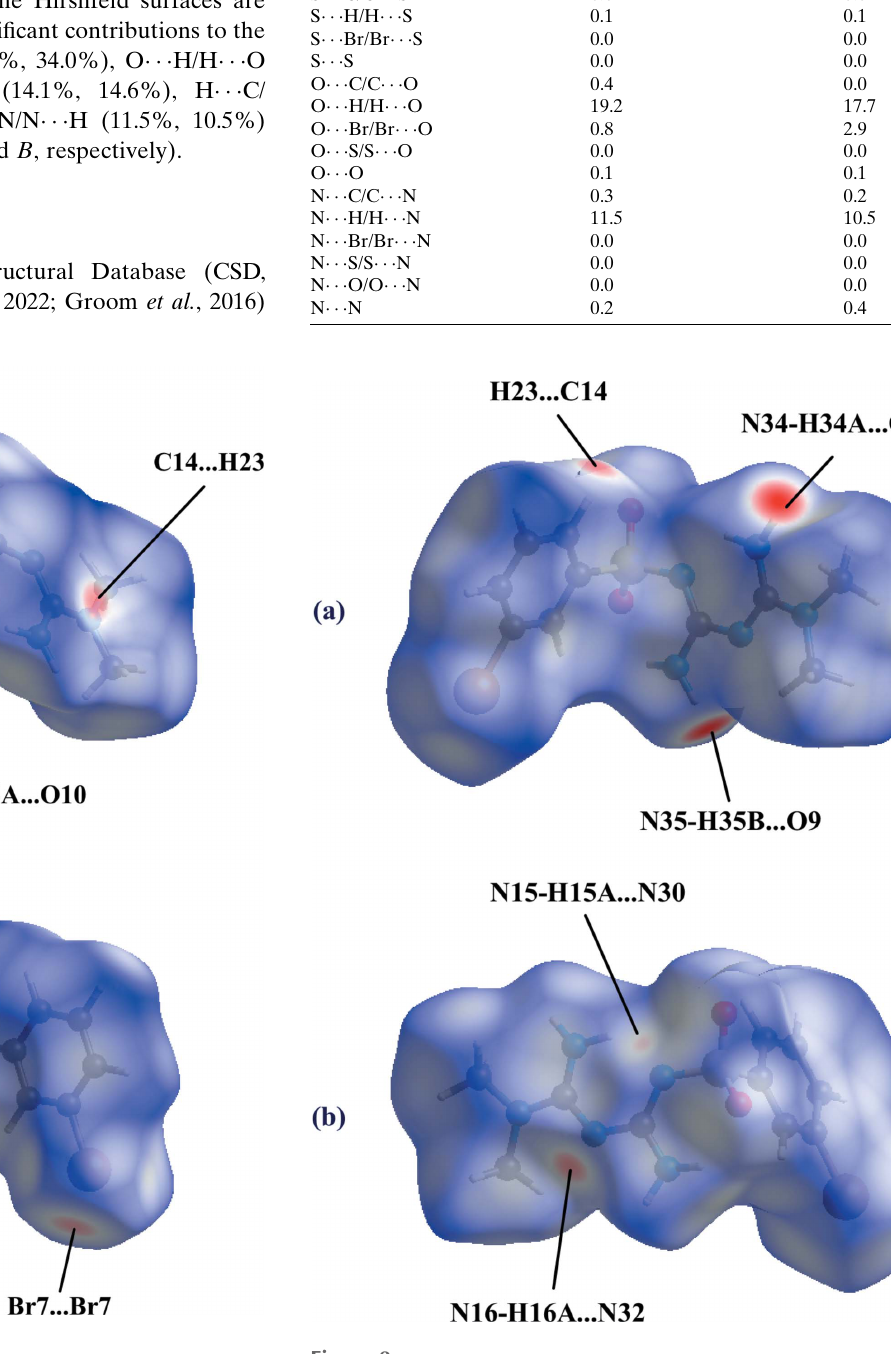
Figure 7 The Hirshfeld surface for molecule A mapped over d norm : ( a ) front view, ( b ) back view.